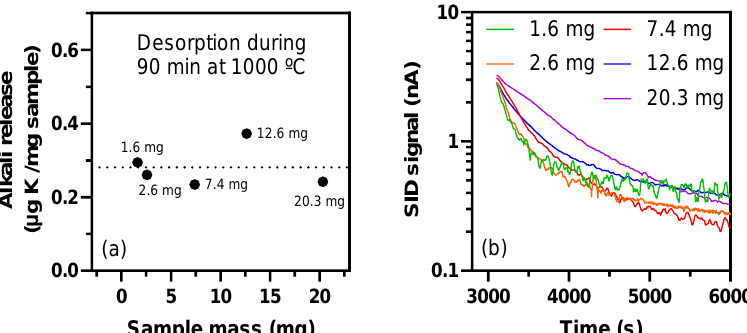
Figure 8. ( a ) Normalized amount of alkali released (µg mg −1 sample) as a function of the ilmenite sample size. The experiments were carried out during 90 min at a constant temperature of 1000 °C in N 2 . The average alkali release of 0.28 µg alkali mg − 1 sample is marked (dotted line). ( b ) Alkali desorption profiles with logarithmic SID intensities as a function of time.